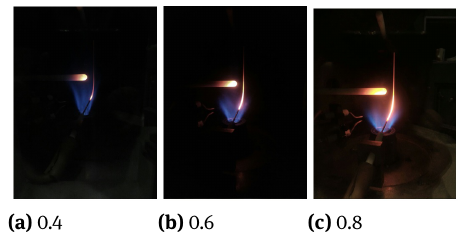
Figure 9: Flame images at different swirl numbers